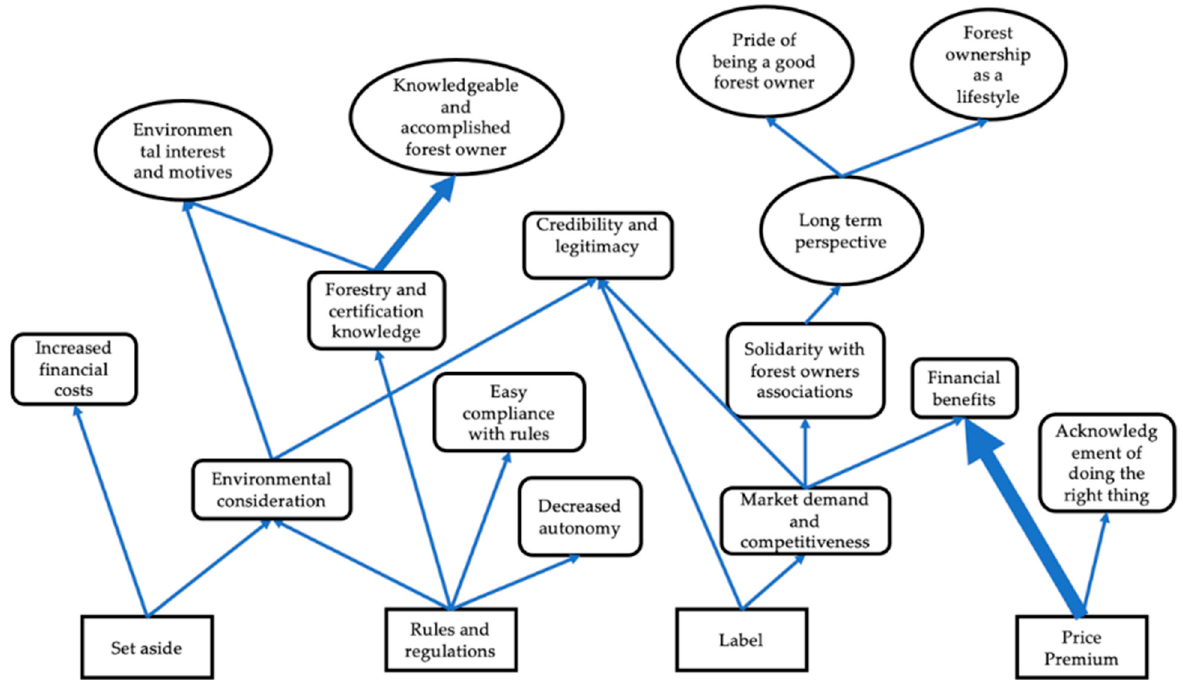
Figure 4. Respondents with forestry as primary occupation and income (N = 6).